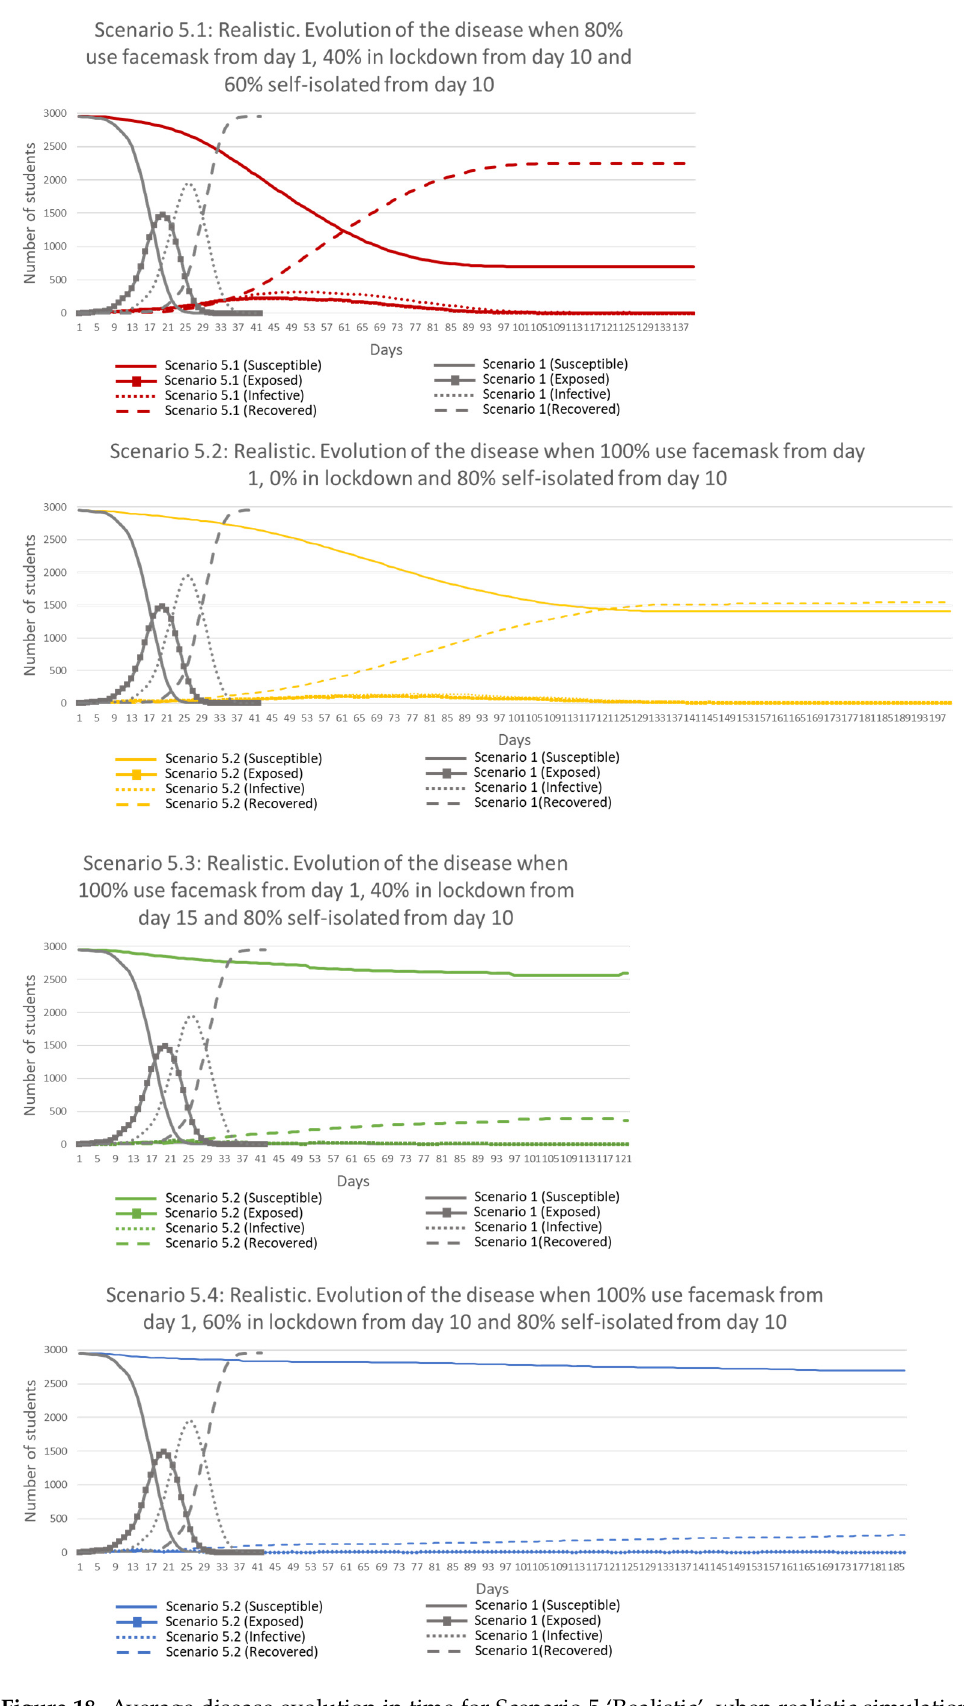
Figure 18. Average disease evolution in time for Scenario 5 ‘Realistic’, when realistic simulations were run. Results are compared against Scenario 1 (grey curves).